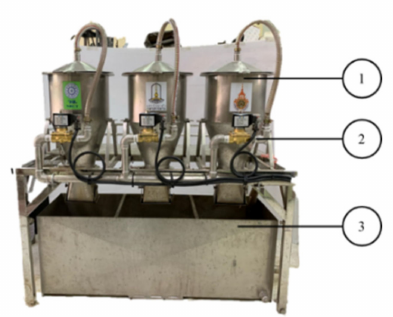
Figure 1. Component details of an automatic soaking and germination accelerator unit: (1) the paddy container has a tight lid, and the paddy capacity size is 1–1.5 kg; (2) solenoid valve for controlling the water spray; (3) reservoir for receiving water from the soaking and germination process for recycling in the system.